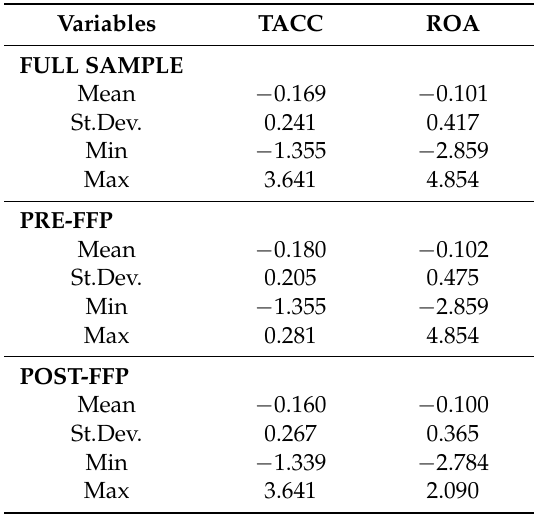
Table 2. Descriptive statistics of sample